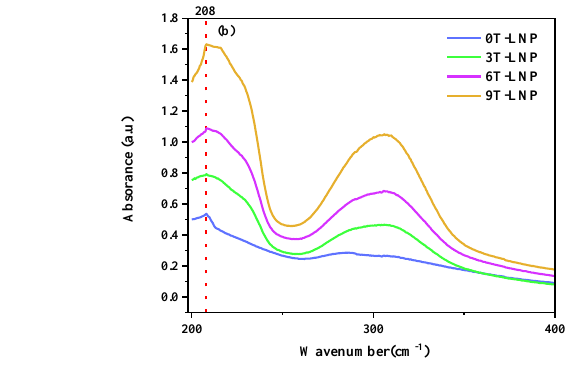
Figure 2. Schematic showing the formation of lignin nanoparticles during the self-assembly process. Route i: Using low molecular weight organosolv lignin as raw materials, ethanol and water as solvent and anti-solvent, lignin nanoparticles were obtained by self-assembly method. Route ii : Tailed lignin nanoparticles were obtained from low molecular weight organosolv lignin using the solvent (ethanol)-antisolvent (water) method with the assistance of syringaldehyde. Route iii : Schematic representation of formation process of the tailed lignin nanoparticles with tunable structures.